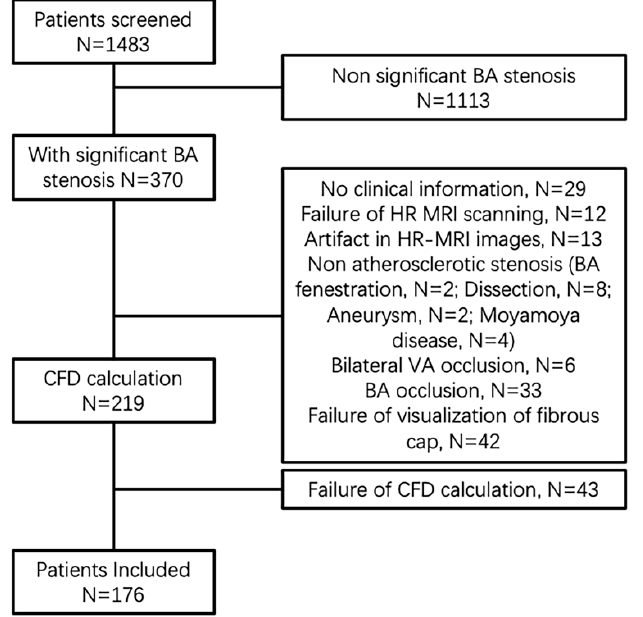
Figure 2. A flow diagram. Table 1. The baseline characteristics.